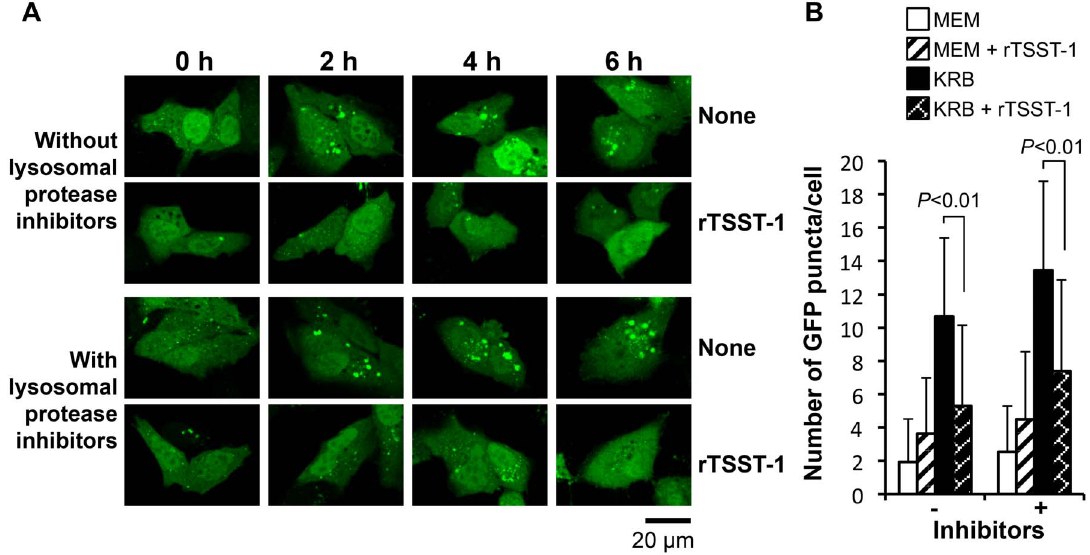
Figure 3. Lysosomal protease inhibitors fail to restore autophagosomes in TSST-1-treated cells. HeLa 229 cells were transfected with pEGFP/hLC3 and autophagy was induced under nutrient-starvation with or without the addition of 10 m g/ml rTSST-1 and lysosomal protease inhibitors. At the indicating time, the autophagosomal accumulation in the cells was observed by GFP puncta under confocal microscope (A). GFP- LC3 puncta at 4 h were counted from 100 cells of 2 independent-experiments (B).